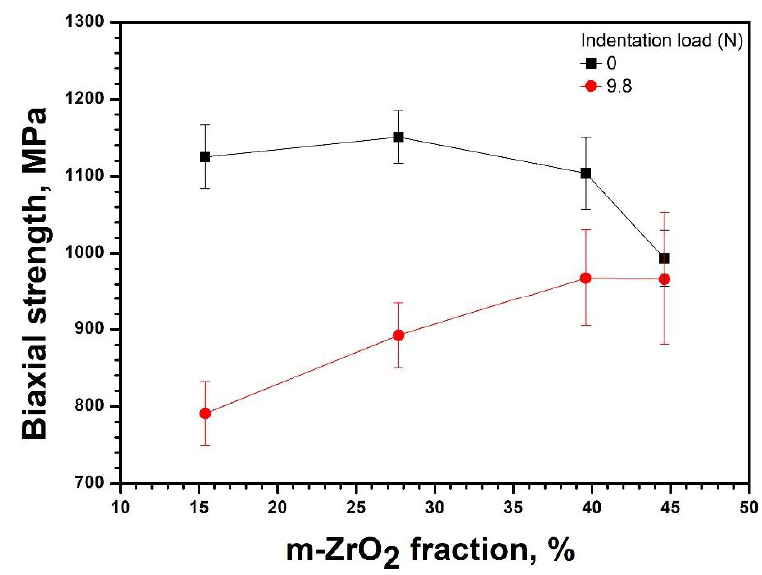
Figure 4. Variation of the biaxial strength of the as-sintered 3Y-TZP and the 3Y-TZP indented at 9.8 N as a function of m-ZrO 2 fraction that is determined by sintering time. The biaxial strength of as-sintered specimens tends to decrease with m-ZrO 2 fraction, but the strength of the identical specimens indented at 9.8 N increases with the fraction. The m-ZrO 2 fractions were obtained by Rietveld refinement of 3Y-TZP sintered at 1550 °C for 2, 8, 14, and 20 h as shown in Figure 2.